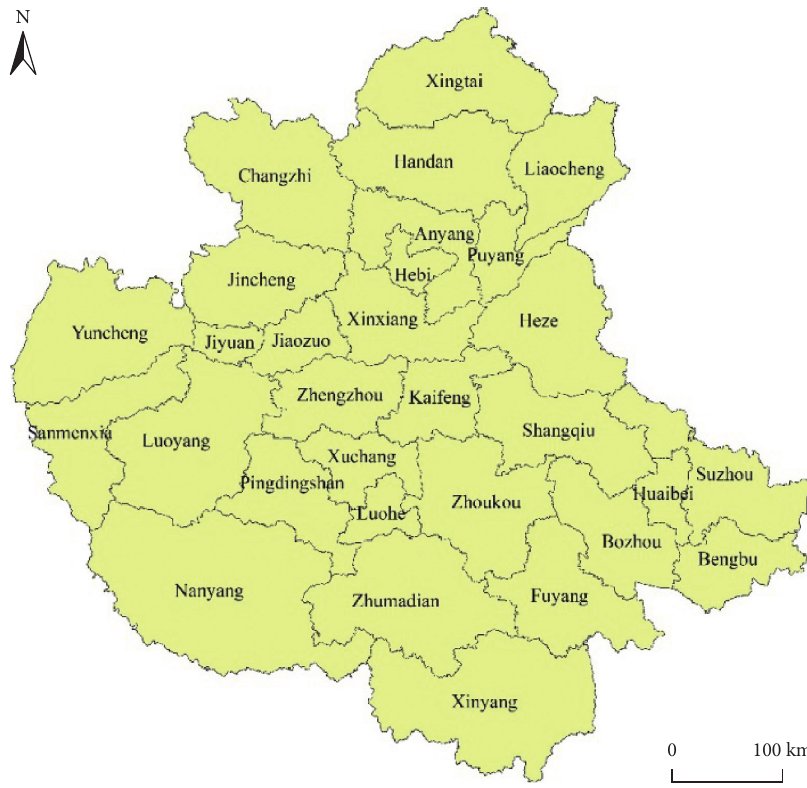
Figure 2: Central Plains City Cluster location Table 2: Logistics industry and economic development comprehensive evaluation index system. System